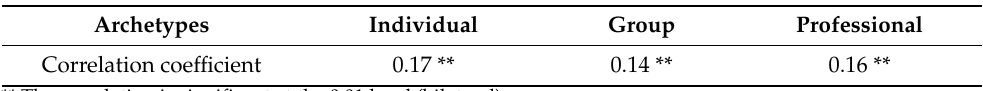
Table 12. Spearman correlations between archetypes and the effects of technostress.